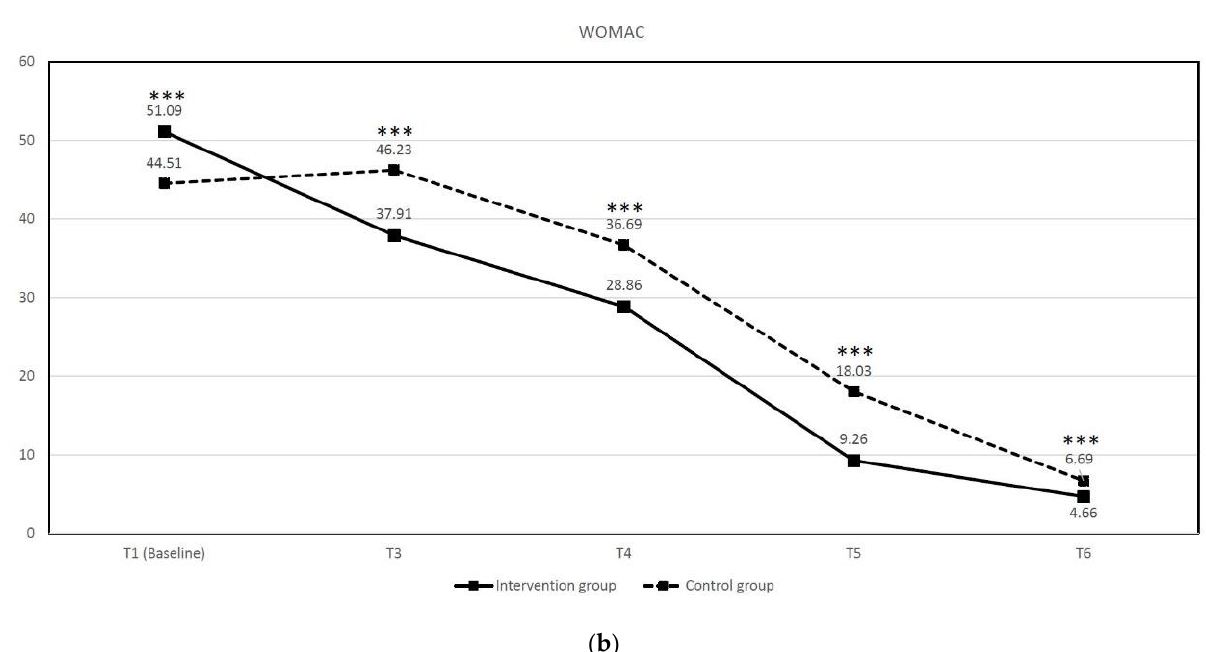
Figure 5. ( a ) Time-course of mean change in WOMAC from baseline to each time point. ( b ) The absolute WOMAC score at each time point in both groups. (* p < 0.05, ** p < 0.01; *** p < 0.001).